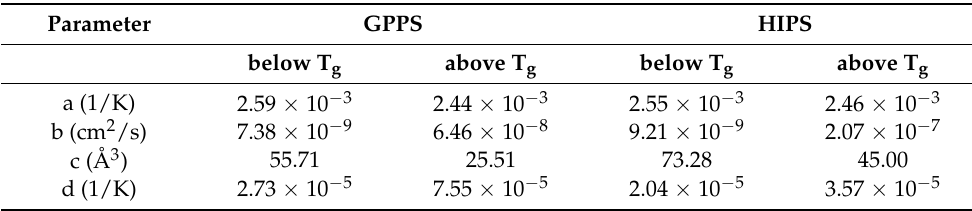
Table 8. Parameters for the prediction of diffusion coefficients according to Equation (3) for GPPS and HIPS below and above